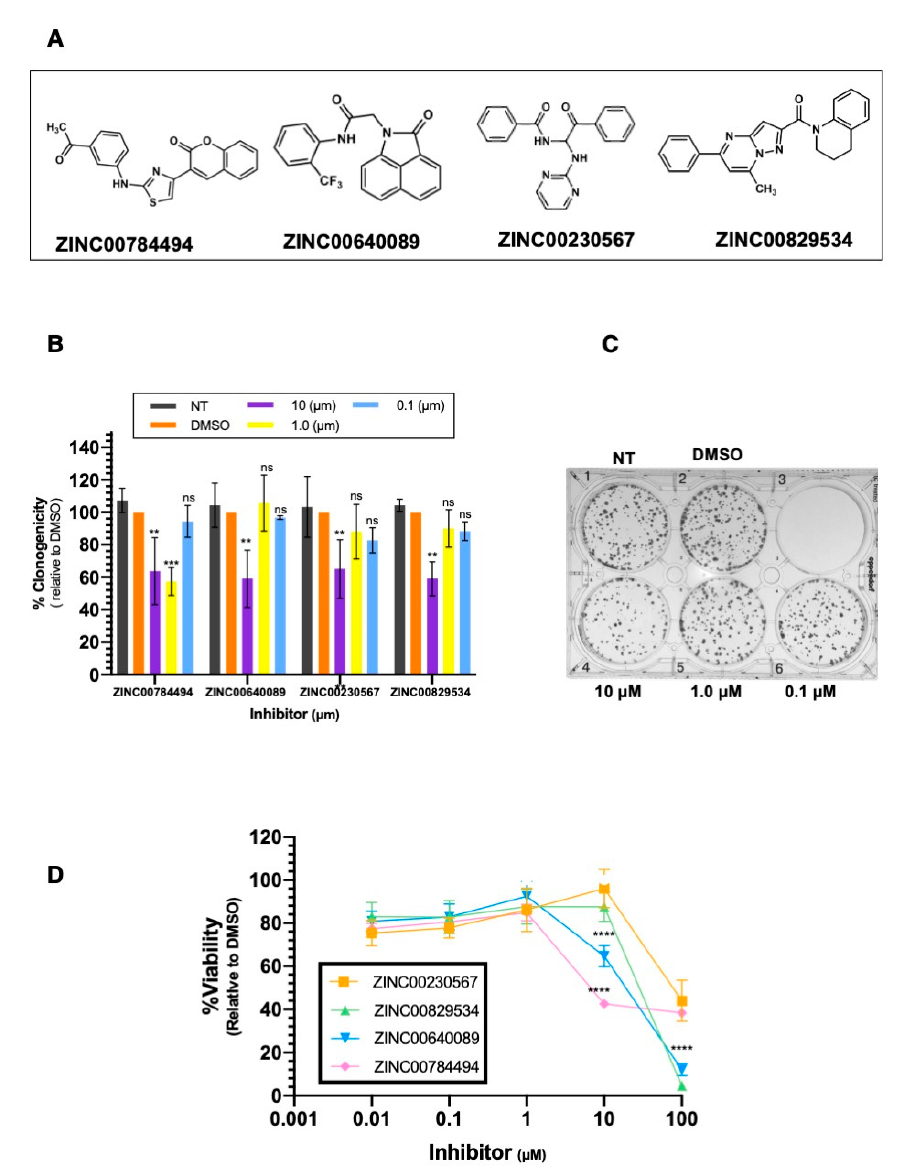
Figure 5. LCN2 inhibitors reduce cell proliferation and cell viability in IBC cells. ( A ) For colony formation assays SUM149 cells were treated with LCN2 inhibitors at 10 µ M, 1 µ M, and 0.1 µ M concentration. ( B ) The percentage of clonogenicity was calculated relative to DMSO. Results are shown as Mean ± SEM of triplicate experiments (** p < 0.01, *** p < 0.001). ( C ) Representative plate showing a colony formation assay of SUM149 cells treated with the LCN2 inhibitor. ( D ) Cell viability was assessed in SUM149 cells with Alamar Blue dye 72 h after LCN2 inhibitor treatment. The percentage of cell viability was calculated relative to DMSO. Results are shown as Mean ± SEM of triplicate experiments (**** p <